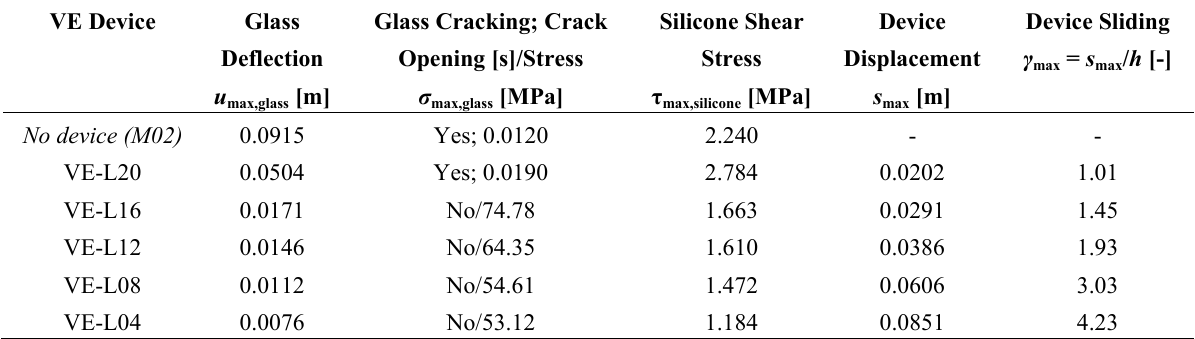
Table 3. Numerical results of parametric analyses (ABAQUS). Glass, silicone and VE devices. VE Device